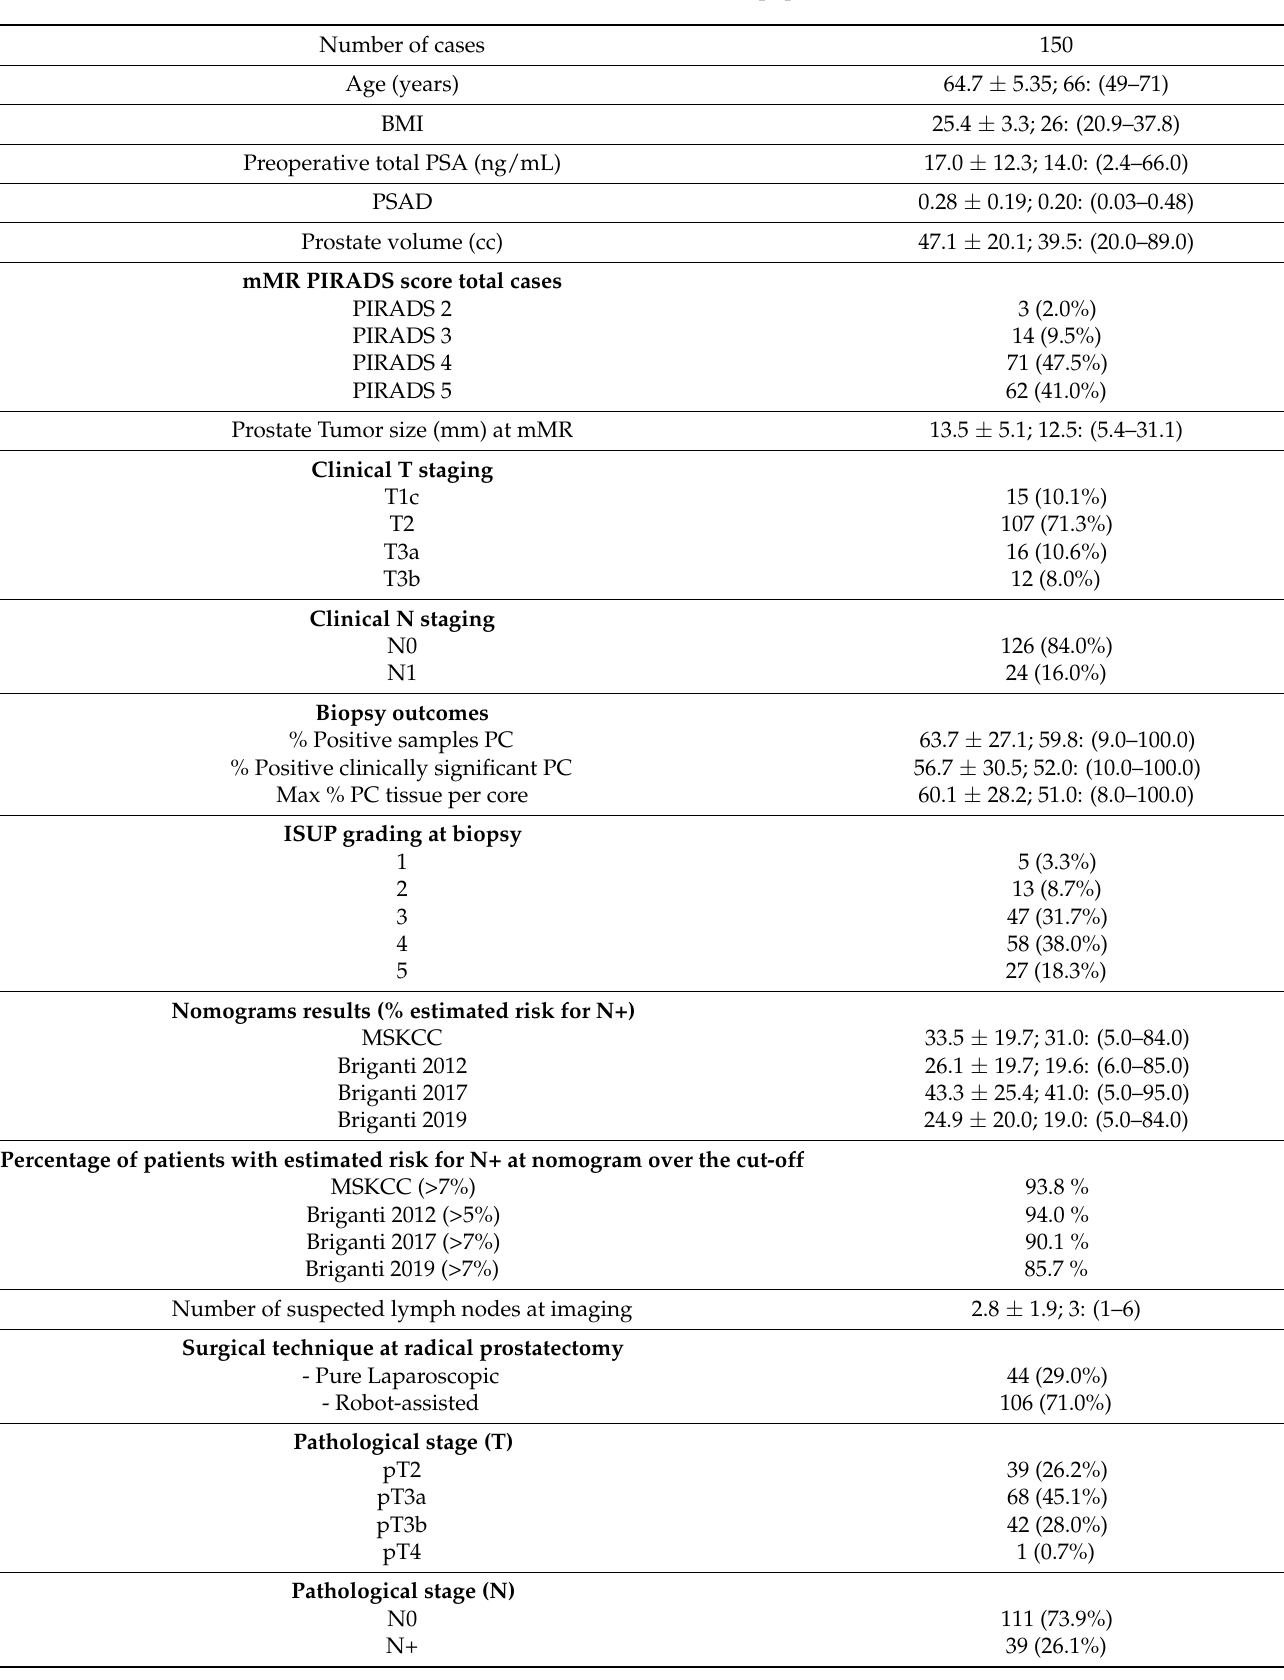
Table 1. Baseline characteristics of the whole